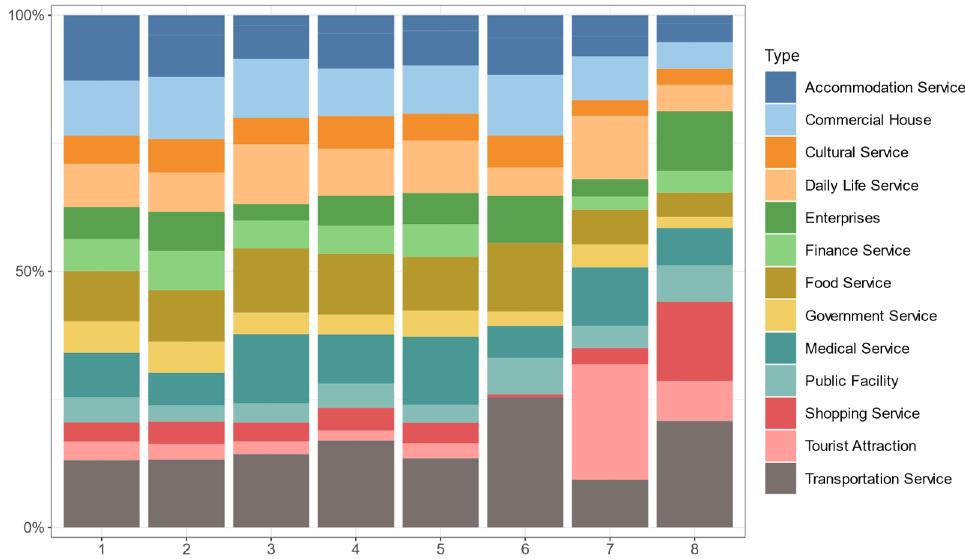
Figure 10. Percentage of different types of POIs in each cluster. Each column (horizontal coordinate) represents a cluster, and its vertical coordinate represents the percentage of different POIs among all POIs in that cluster.